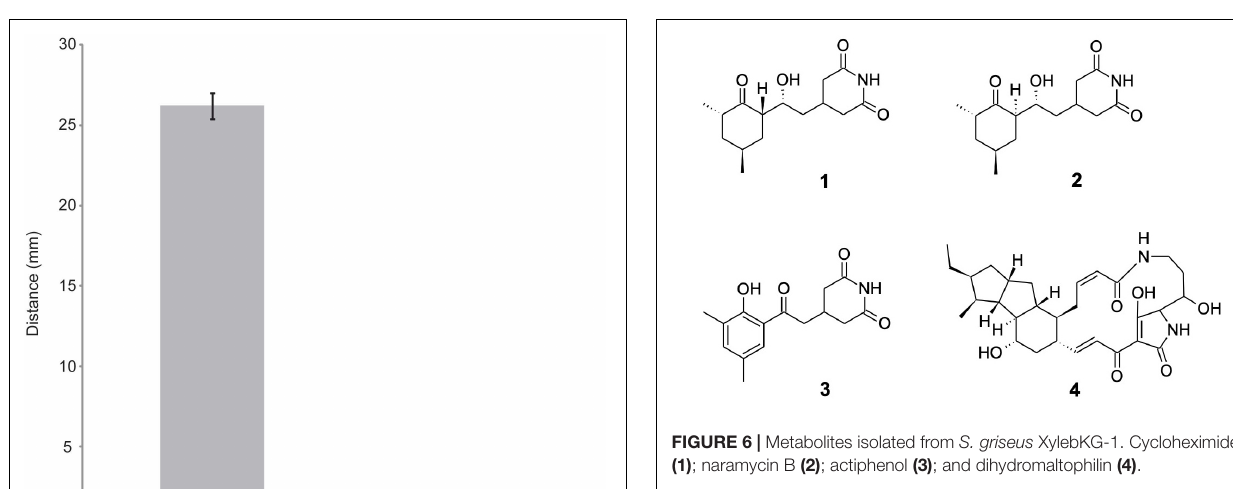
and R. sulphurea (zones of inhibition: 20 µ l, 20/22 mm; 2 µ l, 12/13 mm). Naramycin-B and actiphenol were non-inhibitory